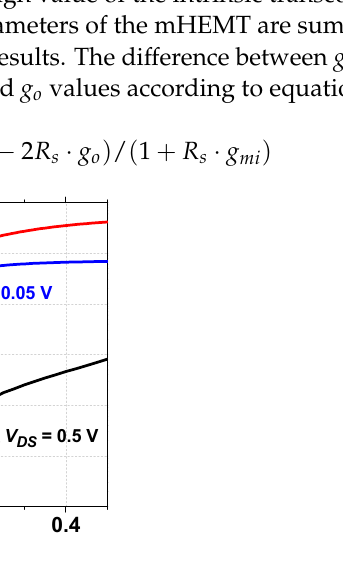
Figure 3. Subthreshold characteristics of the mHEMT were measured at V DS = 0.5 V and V DS = 0.05 V, and the gate leakage current was measured at V DS = 0.5 V, respectively.